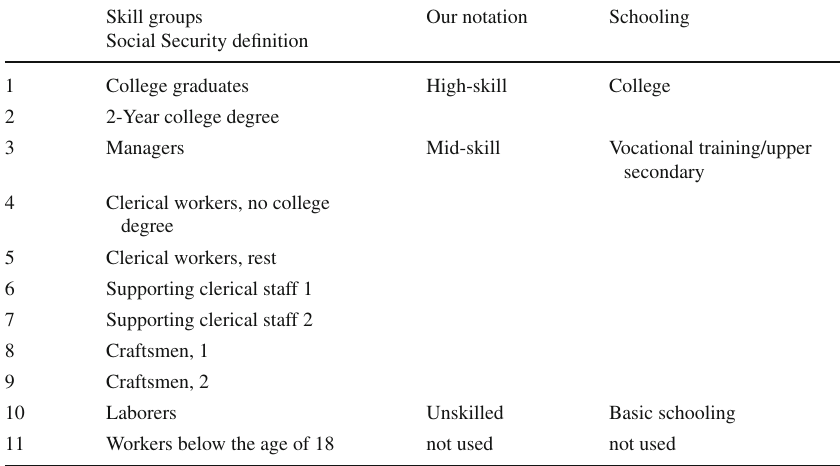
Table 2 Correspondence skill groups-schooling